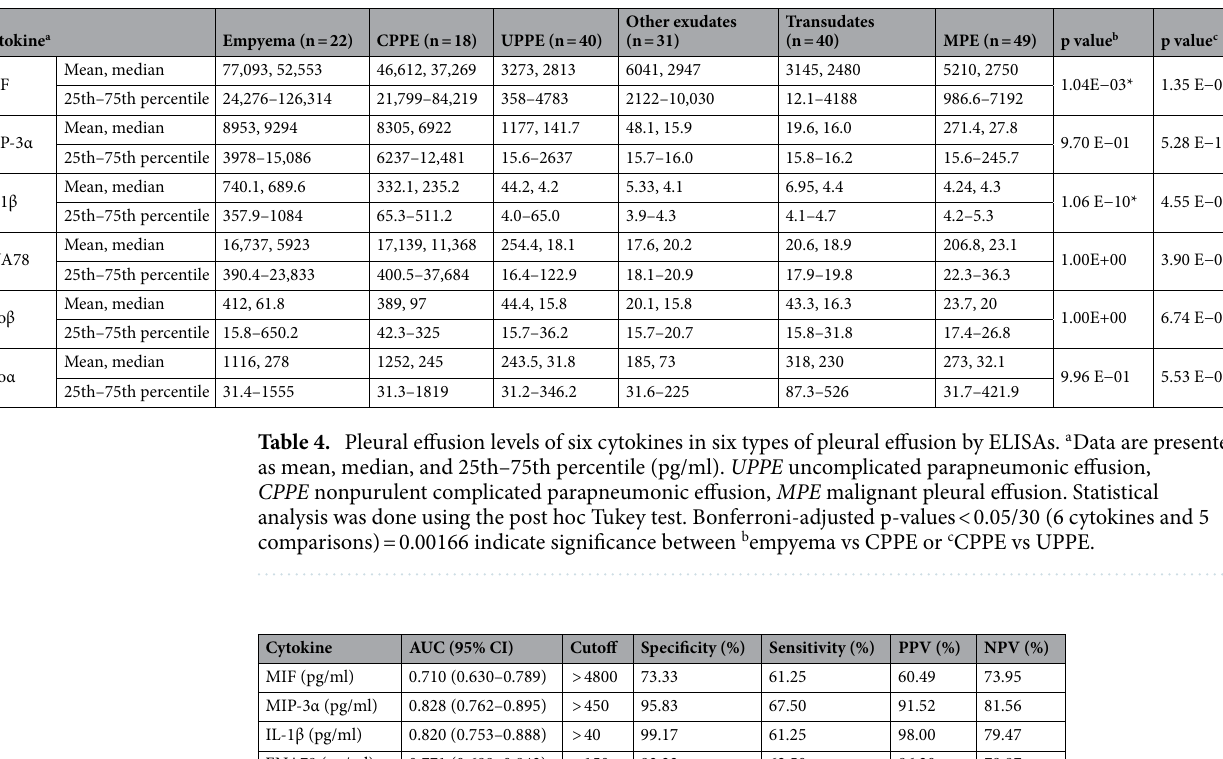
Table 5. Diagnostic accuracy of six cytokines for distinguishing between PPE and noninfectious PE. Parapneumonic effusion (PPE, refers to UPPE, CPPE, and empyema) and noninfectious PE (refers to other exudates, transudates, and MPE) in this study. PPV positive predictive value, NPV negative predictive value, AUC area under ROC curve.